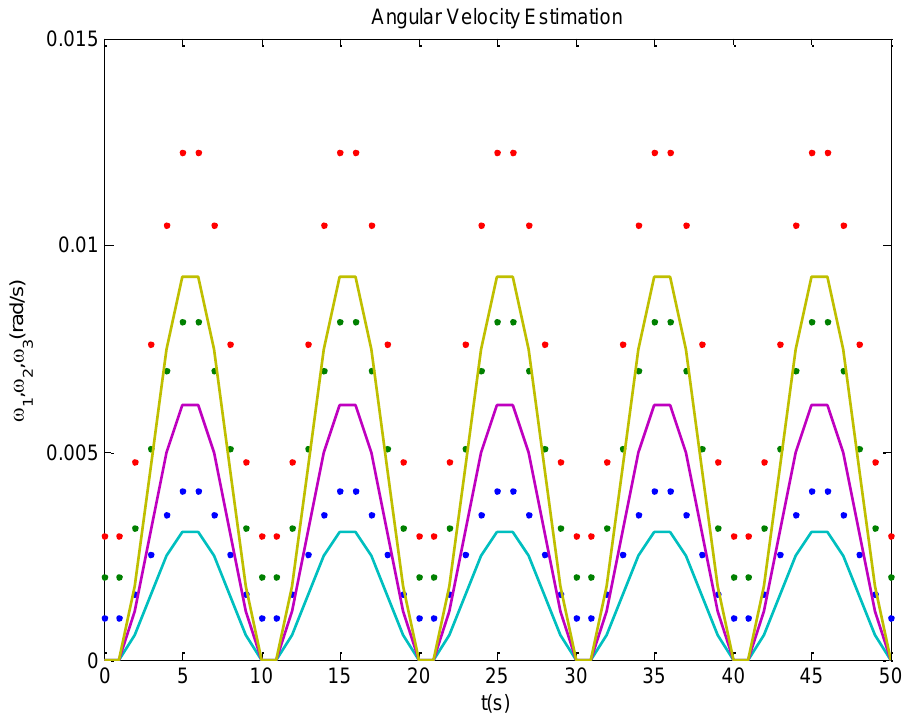
Figure 2. Real (dots) and estimated (solid) angular velocities in a simulated case, where a Kalman filter observer based on Equations (19) and (20) was used. The filter is not able to correctly estimate the velocity components, since the model used is not observable.